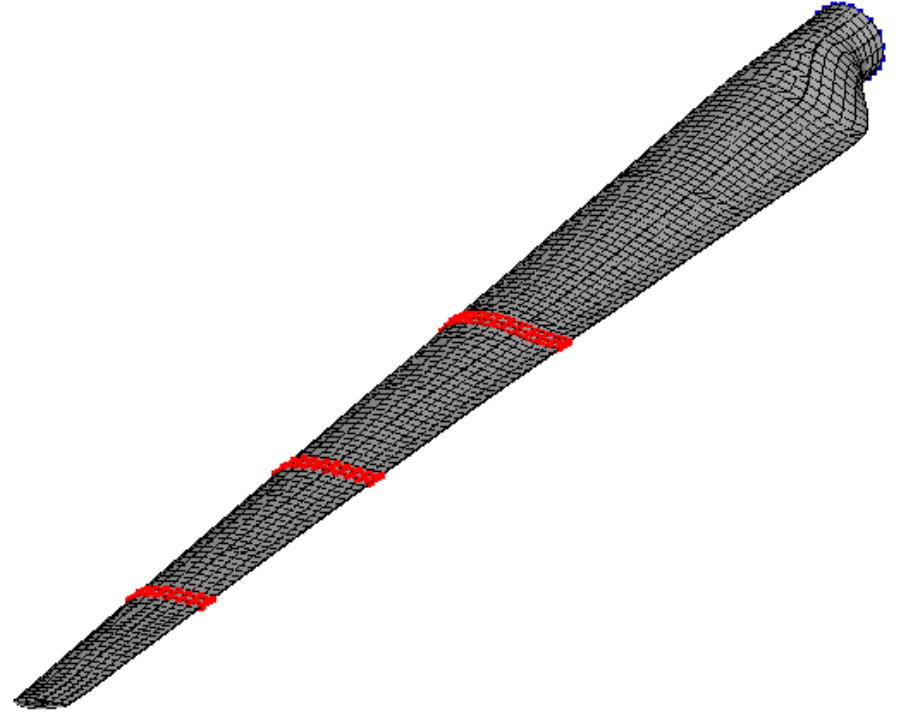
Figure 9. The meshed FE model generated in CalculiX.